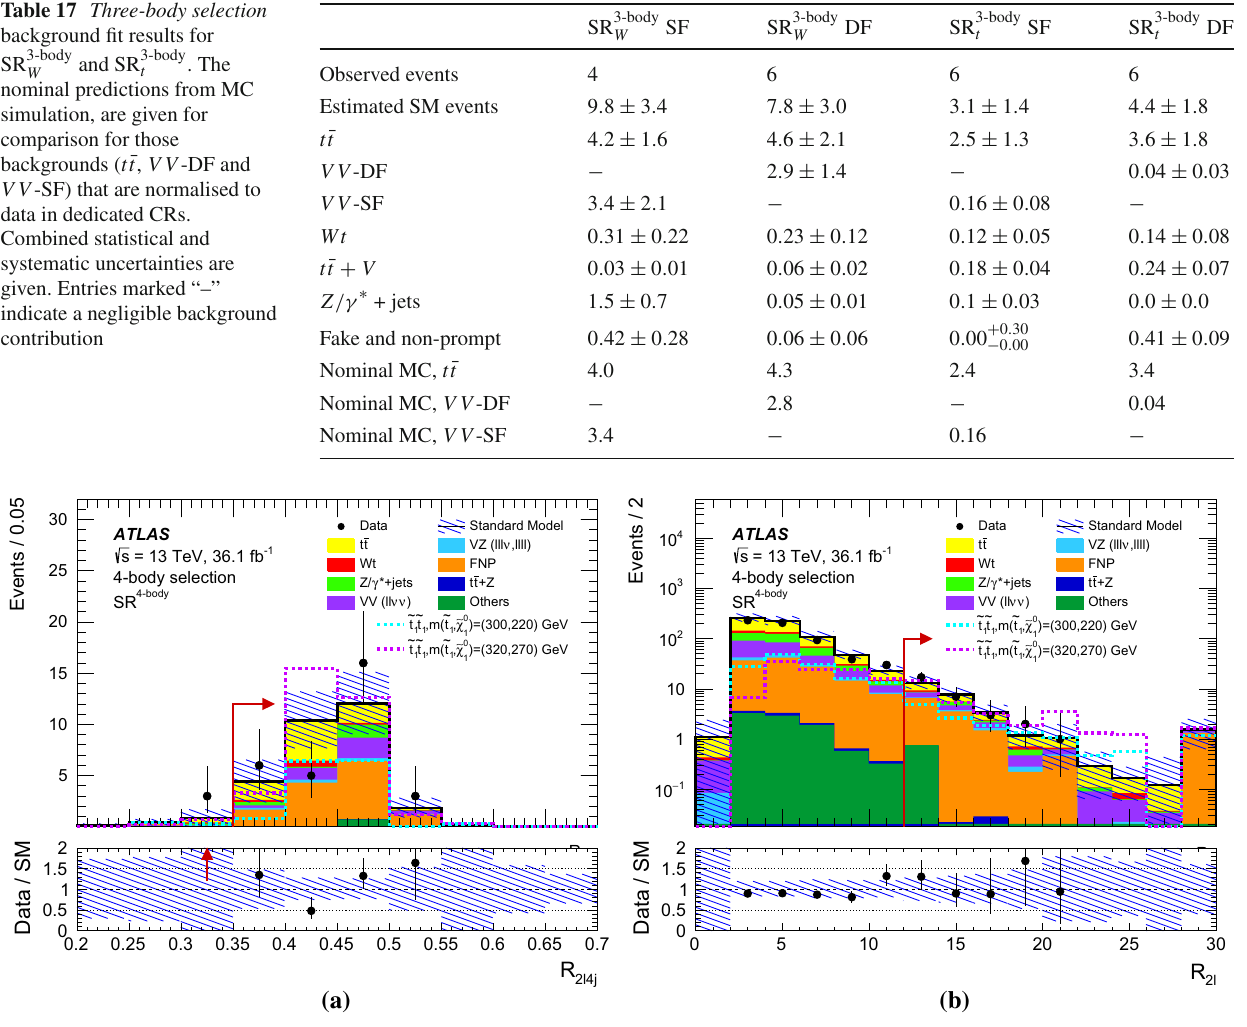
Fig. 8 Four-body selection distributions of a R 2 (cid:3) 4 j and b R 2 (cid:3) for the fit to the data has been performed. The counting uncertainty on data − body is also shown by the black error bars. The rightmost bin of each plot events satisfying all the SR 4 selections except for the one on the includes overflow events. Reference top squark pair production signal variable shown in the figure, after the background fit. The contributions models are overlayed for comparison. Red arrows indicate the signal from all SM backgrounds are shown as a histogram stack; the hatched region selection bands represent the total uncertainty in the background predictions after